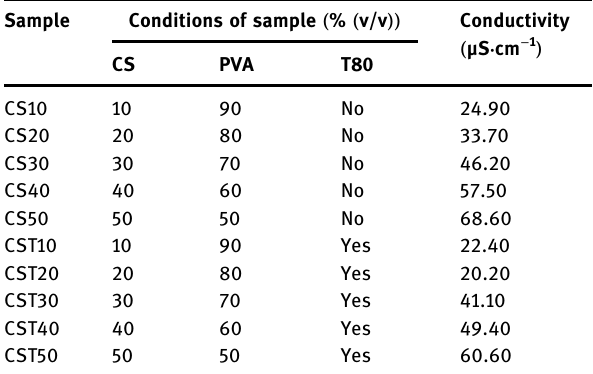
Table 1: Conditions and conductivity of all